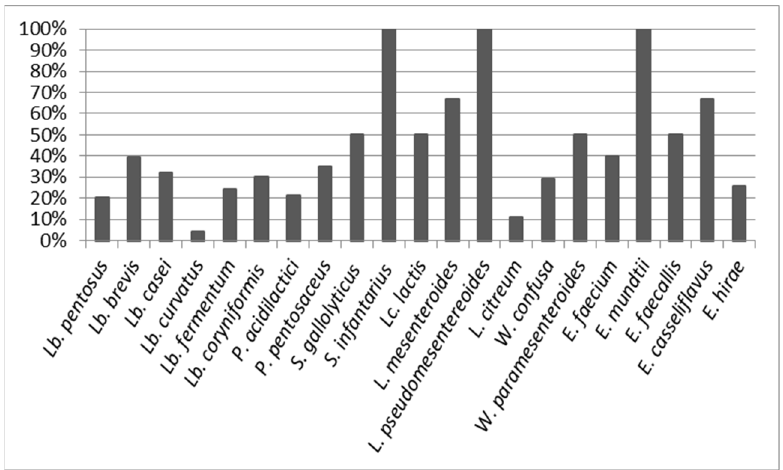
Figure 2. Percentage of biodiversity of the species identified in the analysed samples.